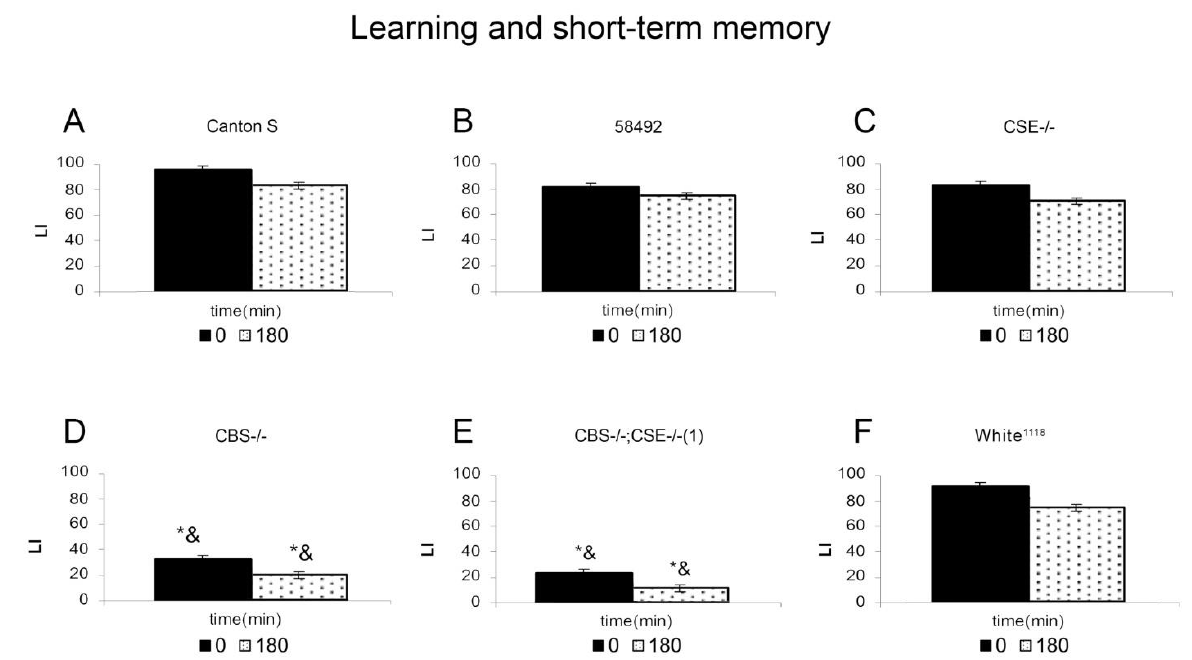
Figure 1. Dynamics of learning acquisition and short-term memory retention of conditioned courtship suppression in mutant males. Males from Canton-S ( A ), 58492 ( B ), CSE-/- ( C ), CBS-/- ( D ), CBS-/- ; CSE-/- (1) ( E ), and white 1118 ( F ) strains were tested. Abscissa: time after training (min); ordinate: LI—learning index, standard units. The sample size for each time point was 20 males. *—LI significantly lower than that 58492 strain under similar conditions (two-sided randomization test, α R < 0.05); &—LI significantly lower than that of wild type Canton-S strain under similar conditions (two-sided randomization test, α R < 0.05).